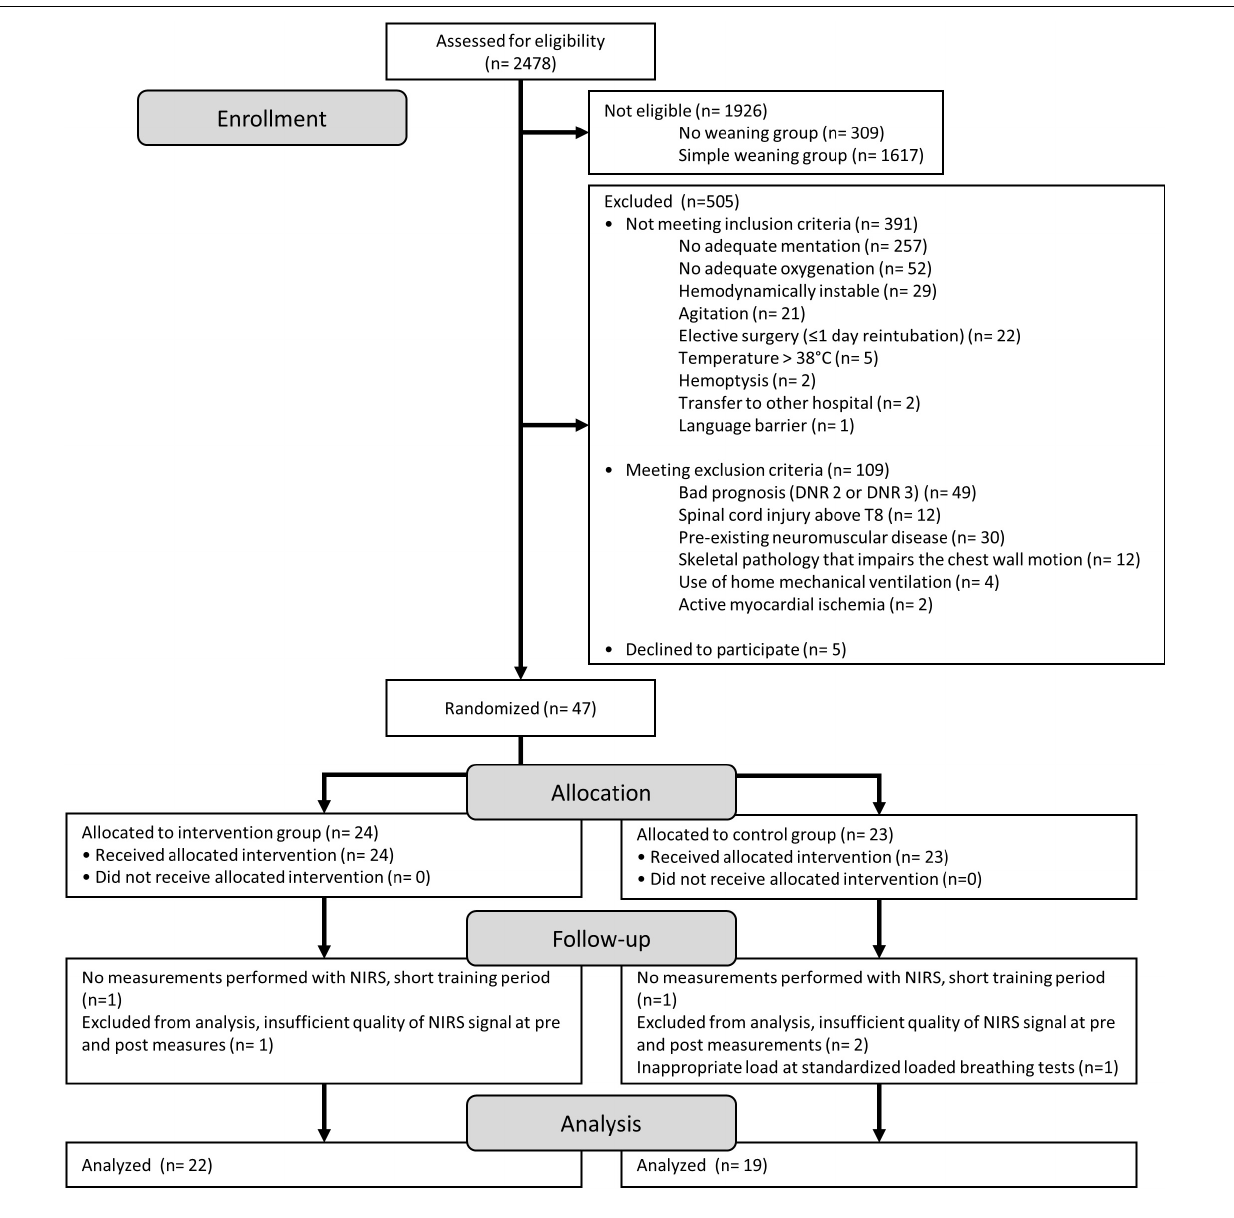
FIGURE 3 | Flowchart of all patients who were screened for eligibility for the